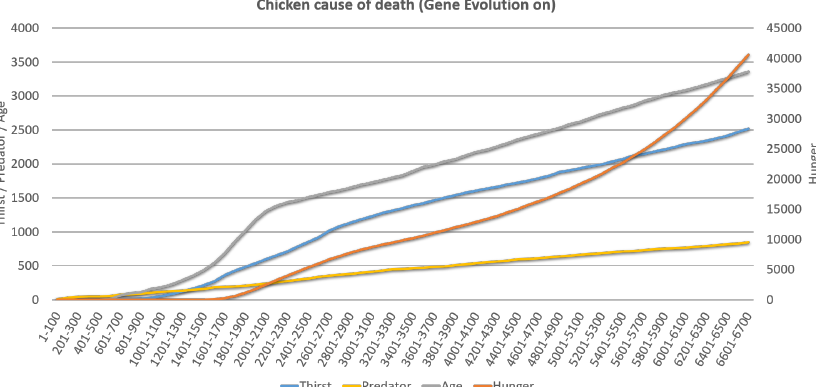
Figure 16. The diagram shows the cause of deaths for the Chicken population with the new